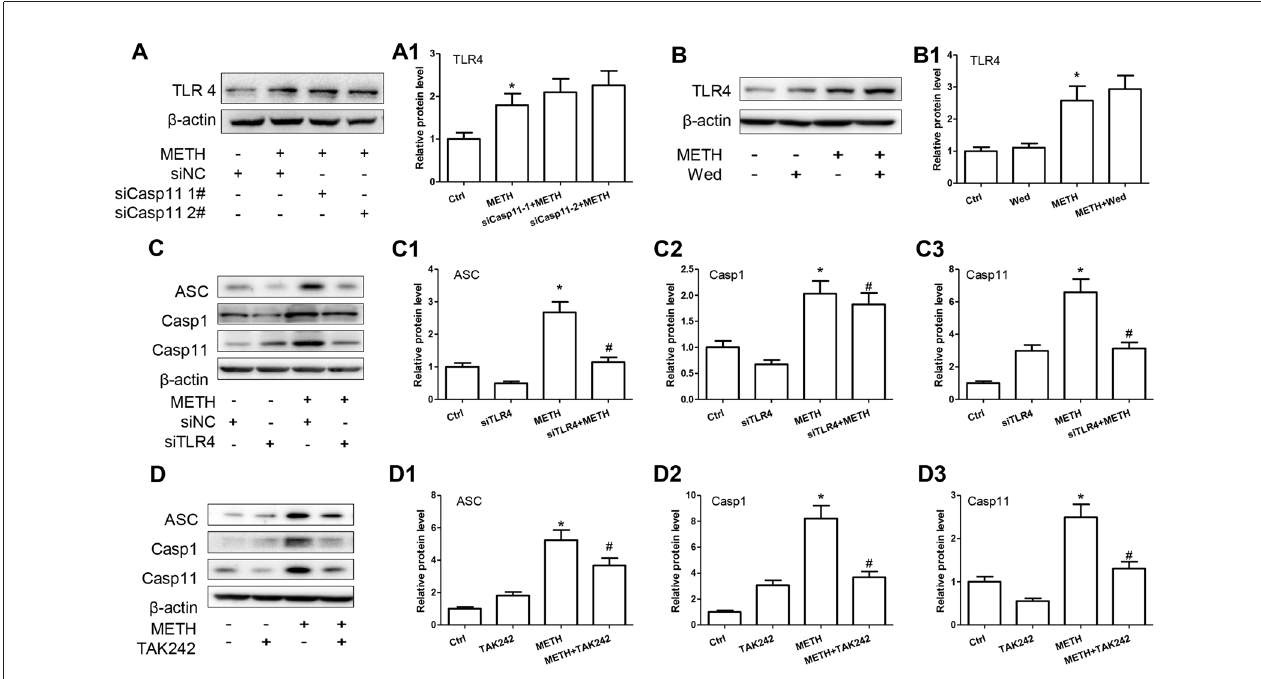
FIGURE 5 | Caspase-11 is involved in TLR4-mediated IL-1 β and IL-18 expression in METH-exposed astrocytes. Primary cultured astrocytes transfected with siRNAs targeting Caspase-11 (A,A1) , TLR4 (C–C3) or control siRNA for 24 h followed by METH (2 mM) treatment for 24 h. Cells were exposed to Wed (30 µ M) (B,B1) or TAK-242 (100 nM) (D–D3) for 2 h prior to METH (2 mM) treatment as indicated. Western blot (A–D) and quantitative analyses were performed to determine TLR4, Caspase-11, ASC and Caspase-1 protein expression. All the experiments were repeated three times. Data are expressed as mean ± SD. ∗ p < 0.05